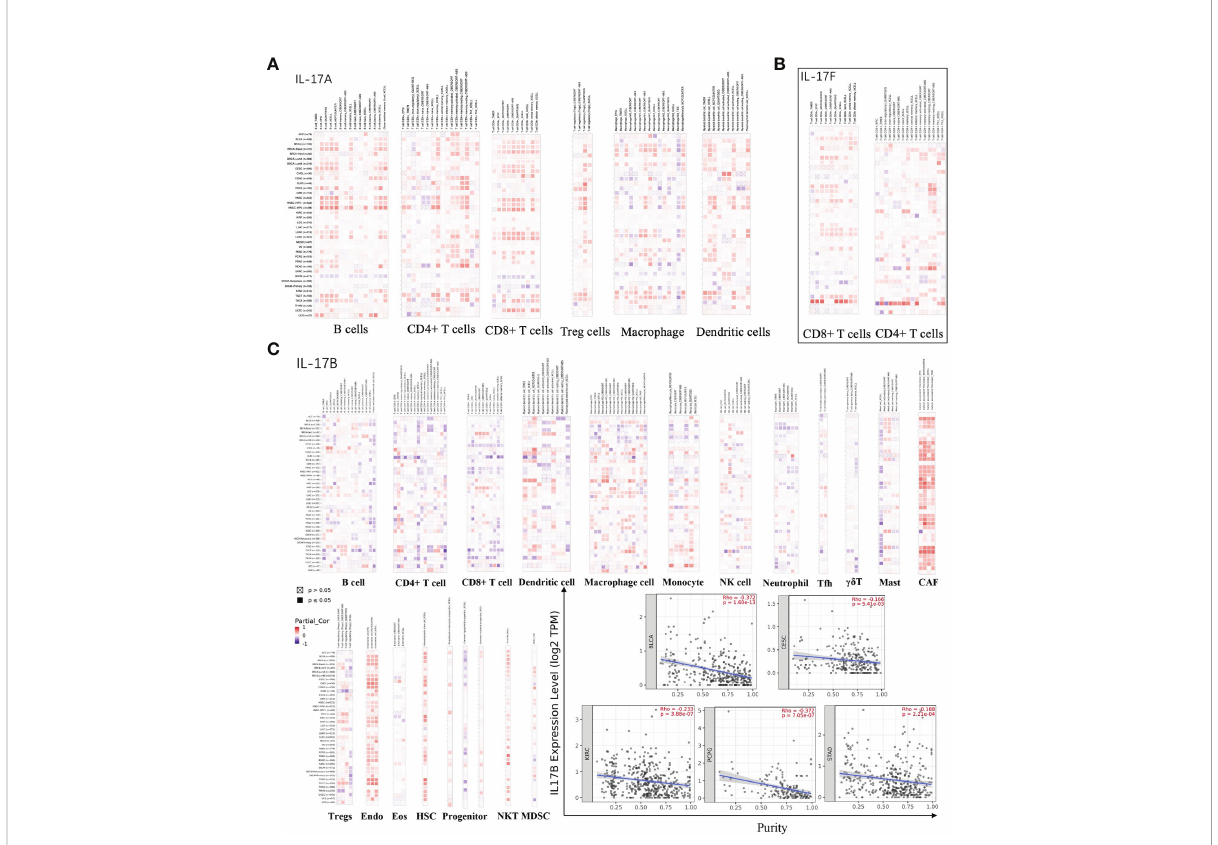
FIGURE 5 (A) The association between IL-17A expression and immune in fi ltration. (B) The association between IL-17F expression and immune in fi ltration. (C) The association between IL-17B expression and immune in fi ltration, and the purity of BLCA, CESC, KIRC, PCPG, and STAD in TCGA